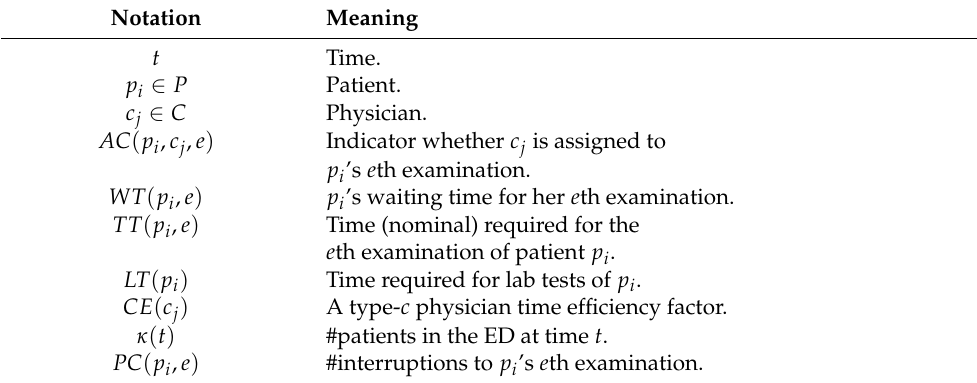
Table 1. Summary of key